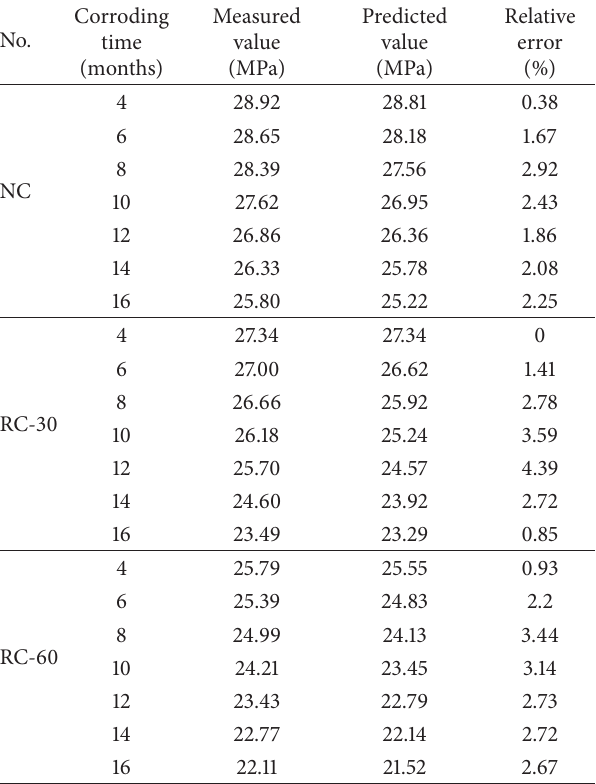
Table 6: Comparison of test value and predicted